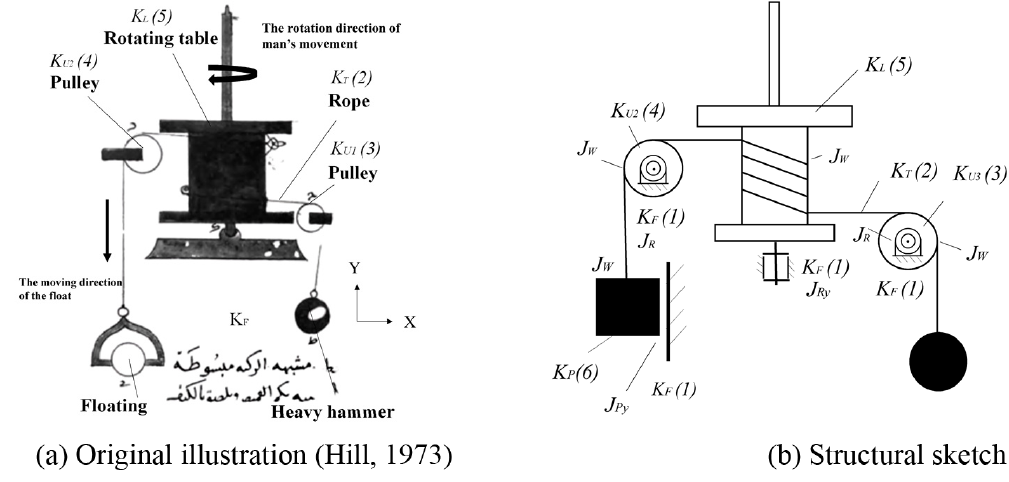
Figure 15. Al-Jazari’s puppet pointing time device.